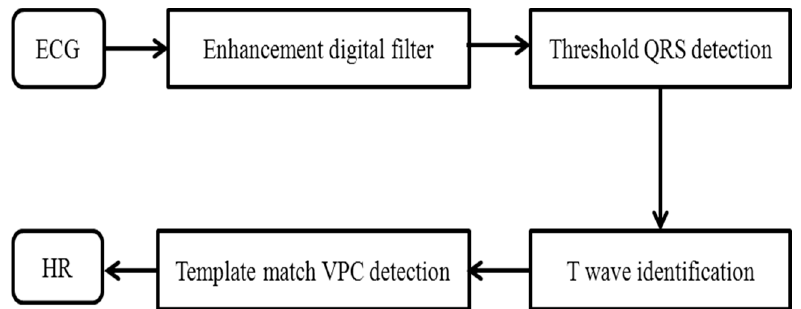
Figure 2. Flow chart for the heart rate detection algorithm. VPC = ventricular premature contraction; HR = heart rate.